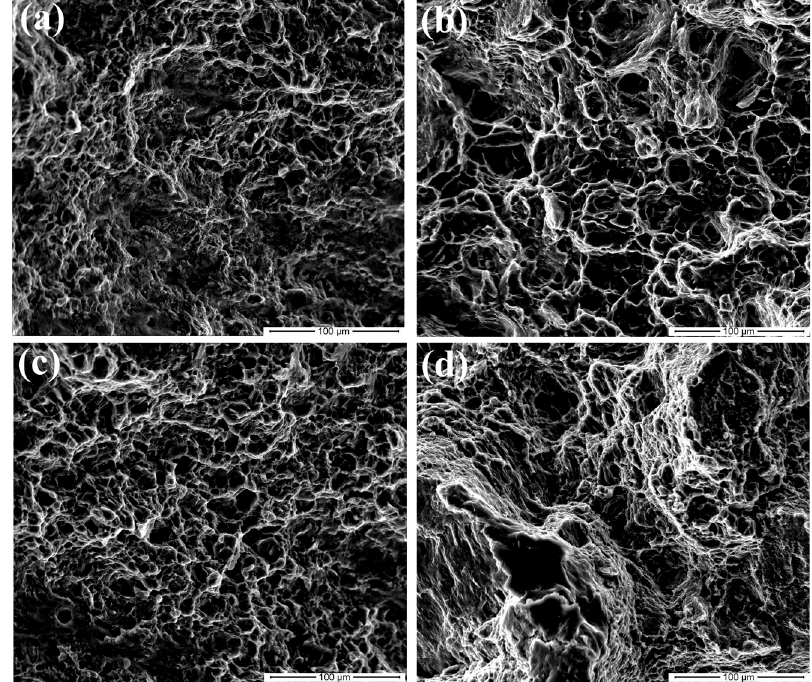
Figure 10. SEM images of tensile fracture for samples HSRMFed with different pass strains ( a ) 0.1, ( b ) 0.16, ( c ) 0.22 and ( d ) 0.35.